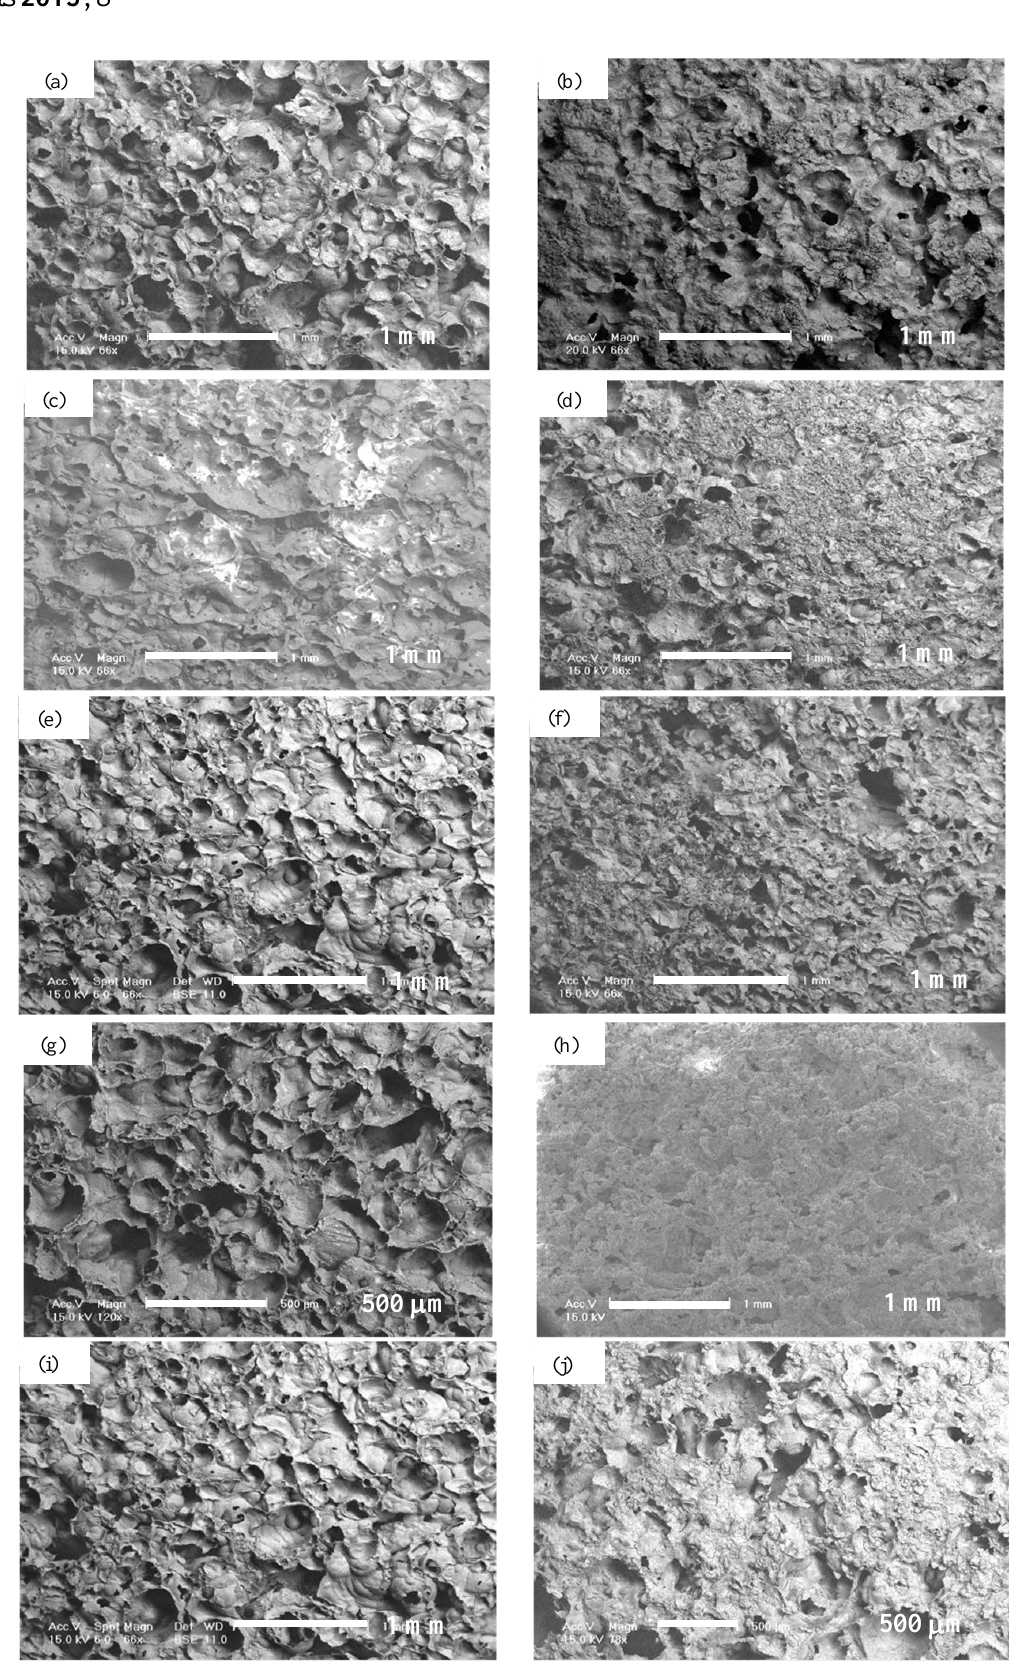
Figure 3. SEM of porous alumina with 10%Ca ( a ); 100%Ca ( b ); 10%P ( c ); 100%P ( d ); 10%Mg ( e ); 100%Mg ( f ); 10%CaP ( g ); 100%CaP ( h ); 10%Ca + P + Mg ( i ); 100%Ca + P + Mg ( j